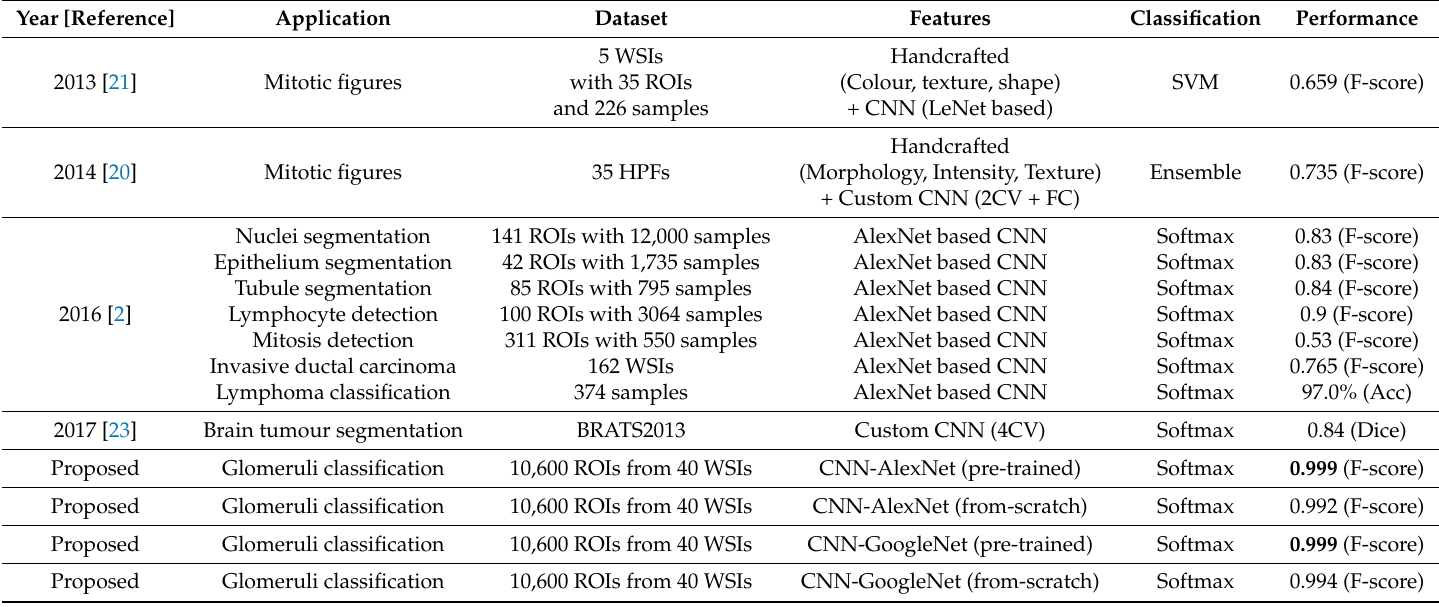
Table 1. Previous work experiments and